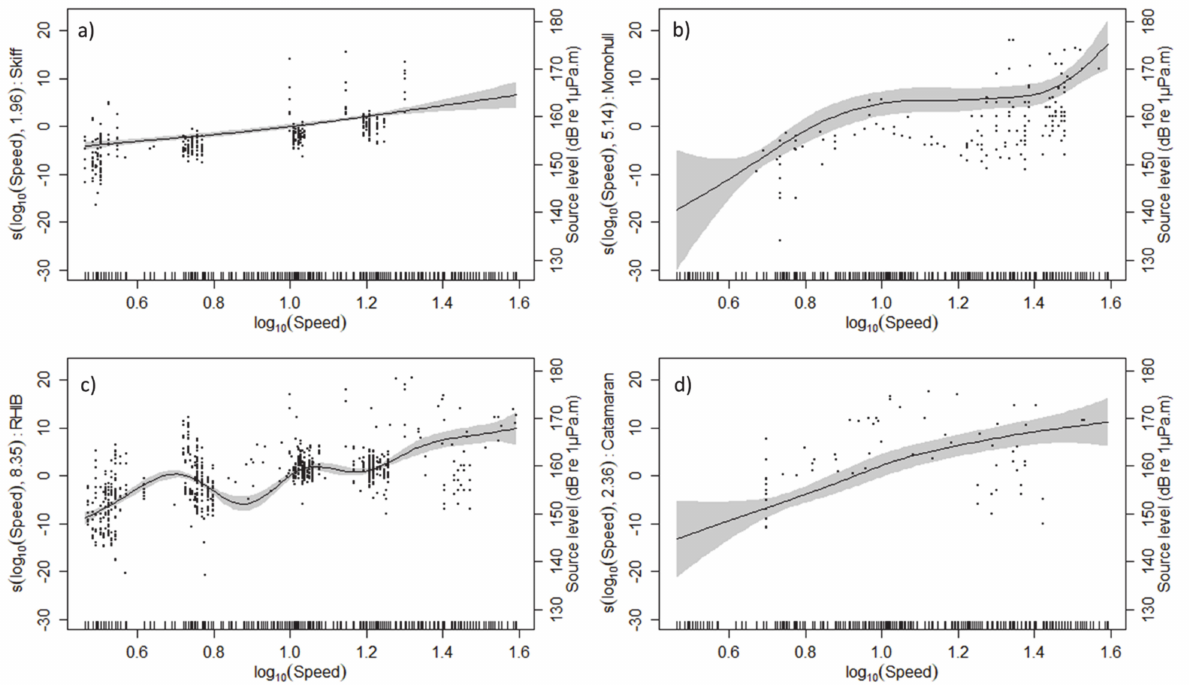
Figure 3. Estimated speed smoothing functions (solid line) with 95% confidence intervals (shaded area) illustrating the relationship between speed and source level (SL) for the four vessel types: Skiff, Monohull, RHIB, and Catamaran ( a – d , respectively). The recorded data were added as points with the secondary y-axis (right). The secondary y-axis also displays the smoother with the estimated intercept added (presenting the fitted values).